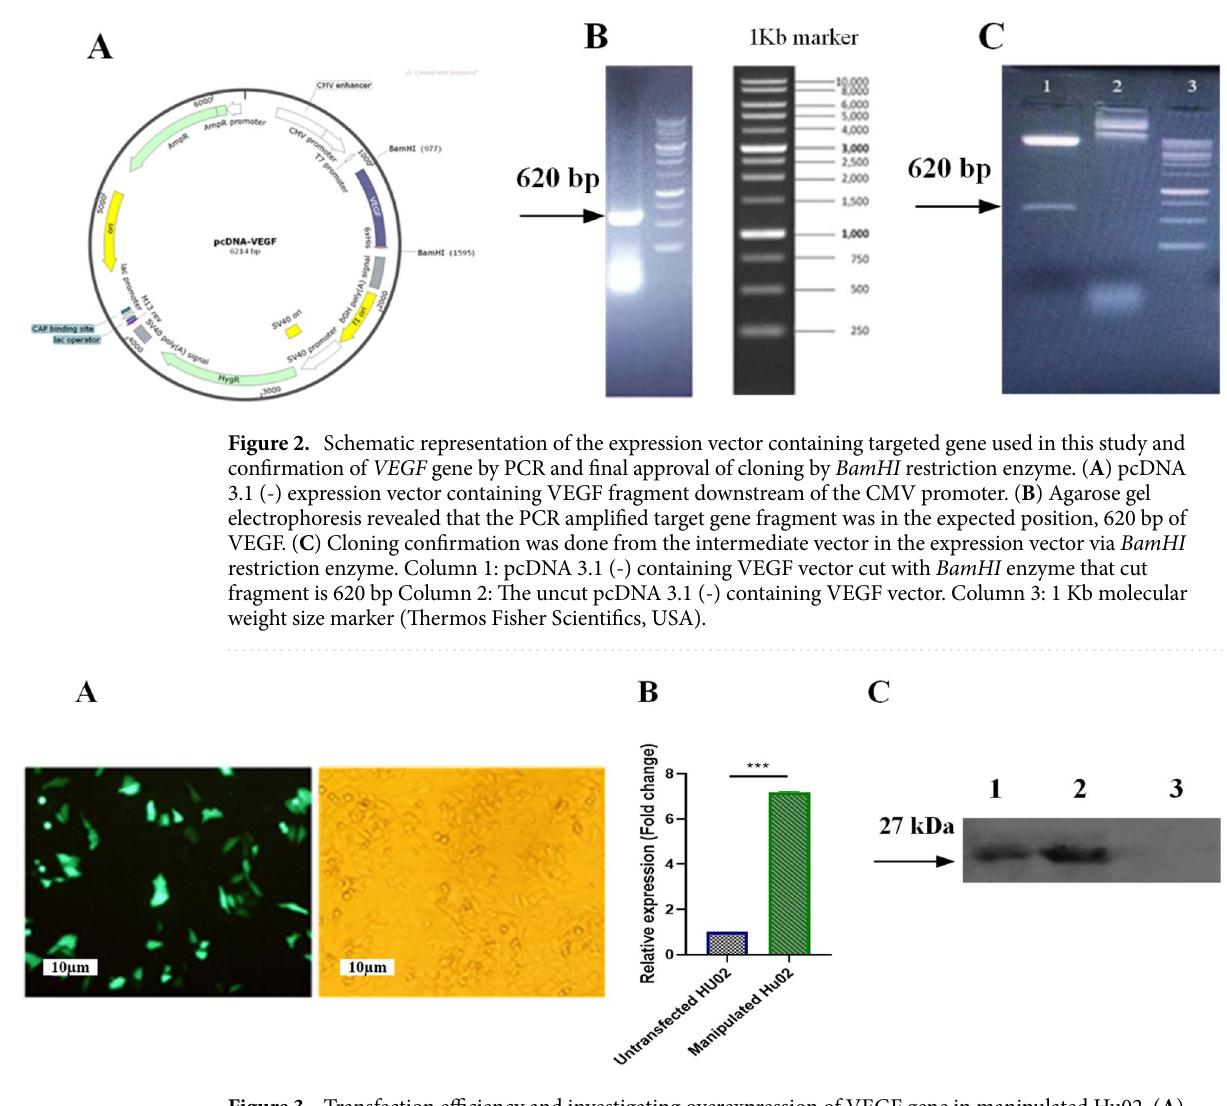
Figure 3. Transfection efficiency and investigating overexpression of VEGF gene in manipulated Hu02. ( A ) Fluorescent image of transfected Hu02 cells expressing EGFP (green fluorescence) as a transfection control. ( B ) Fold change of VEGF mRNA expression in manipulated Hu02 compared to untransfected Hu02 was quantified using qRT-PCR. B-actin was used as an internal control. ( C ) Western blotting analysis of VEGF overexpression among (1) control, (2) transfected, and (3) untransfected groups. (*** P ≤